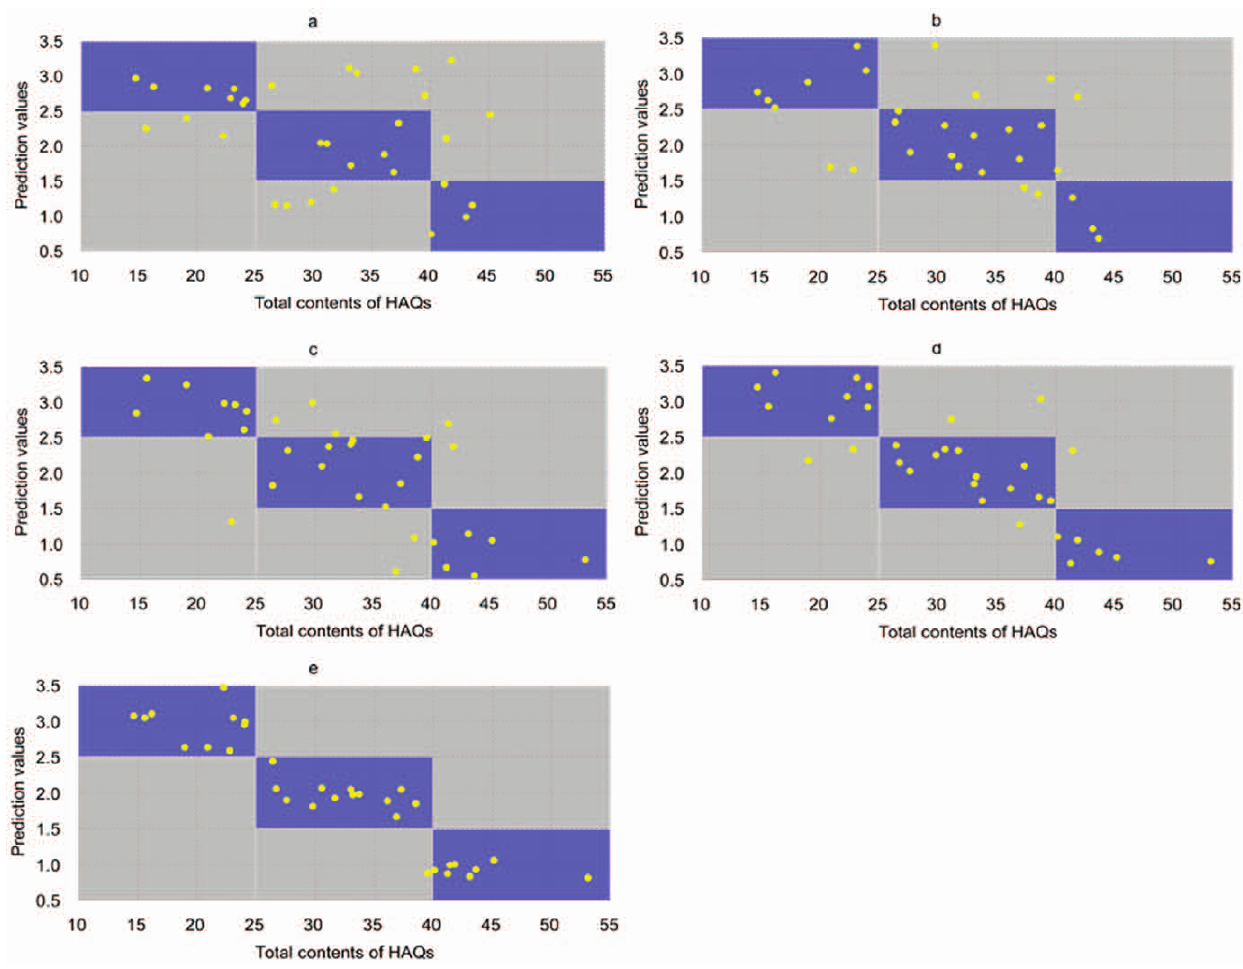
Figure 4. Color-based predictions of the grades of rhubarb samples from the BP network. All the thirty-four samples were counted here, including the training set and the test set. The blue areas indicate correct predictions, and the gray areas indicate incorrect predictions. a, Using the color from the surface of rhubarb without additional coloration as the input parameter, the percentage of correct predictions was 50.0% (17 correct predictions in 34 samples). b, When the colors of the fracture surfaces without development were input, the percent of correct predictions was 64.7% (22 correct predictions in 34 samples). c, When the color-enhanced fracture surfaces were analyzed, the percent of correct predictions was 73.5% (25 correct predictions in 34 samples). d, Using the powder without coloration as the input, the percent of correct predictions was 79.4% (27 correct predictions in 34 samples). e, Analysis of the powder after color development yielded predictions that were 91.2% accurate (31 correct predictions in 34